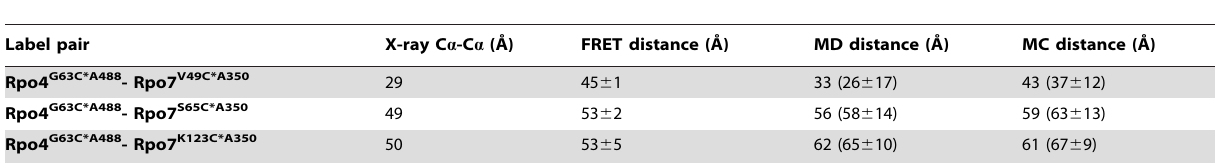
Table 3. Comparison of experimental and calculated mean distances for the fluorophore pairs.